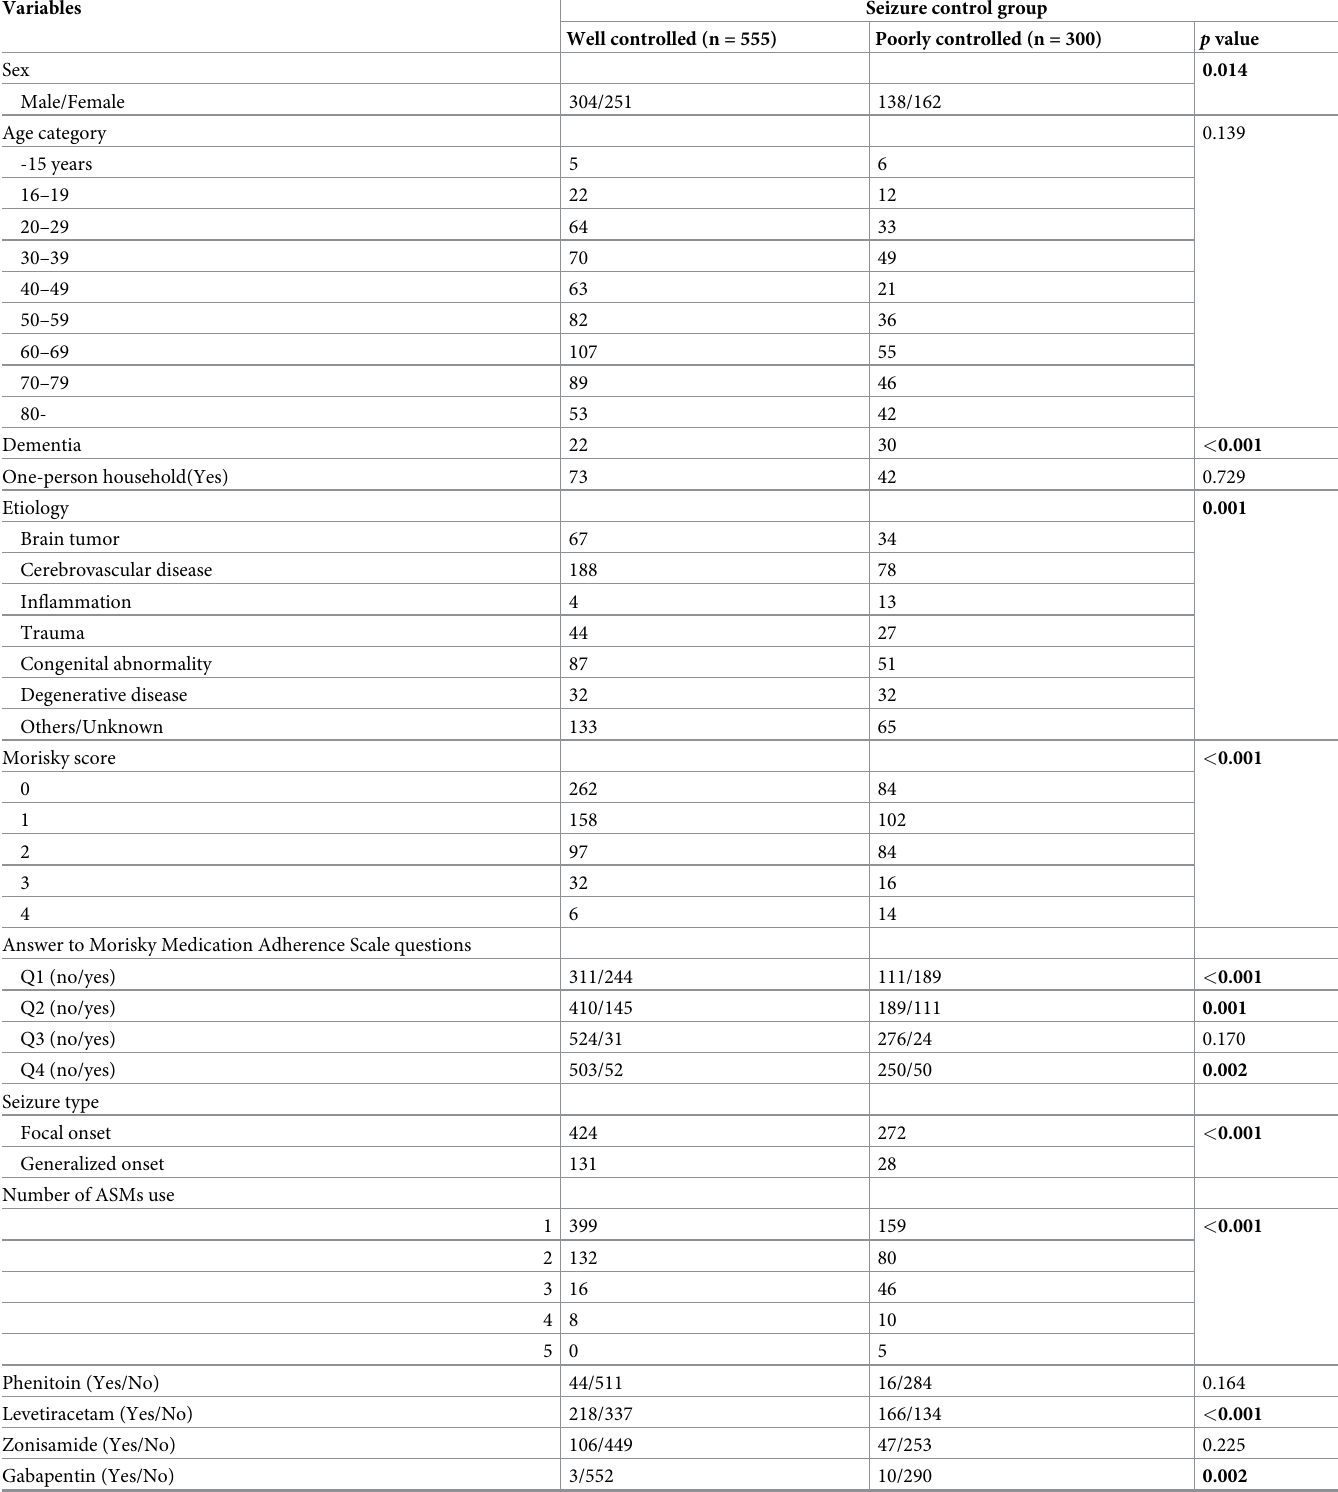
Table 1. Comparison of variables between well and poorly controlled seizure